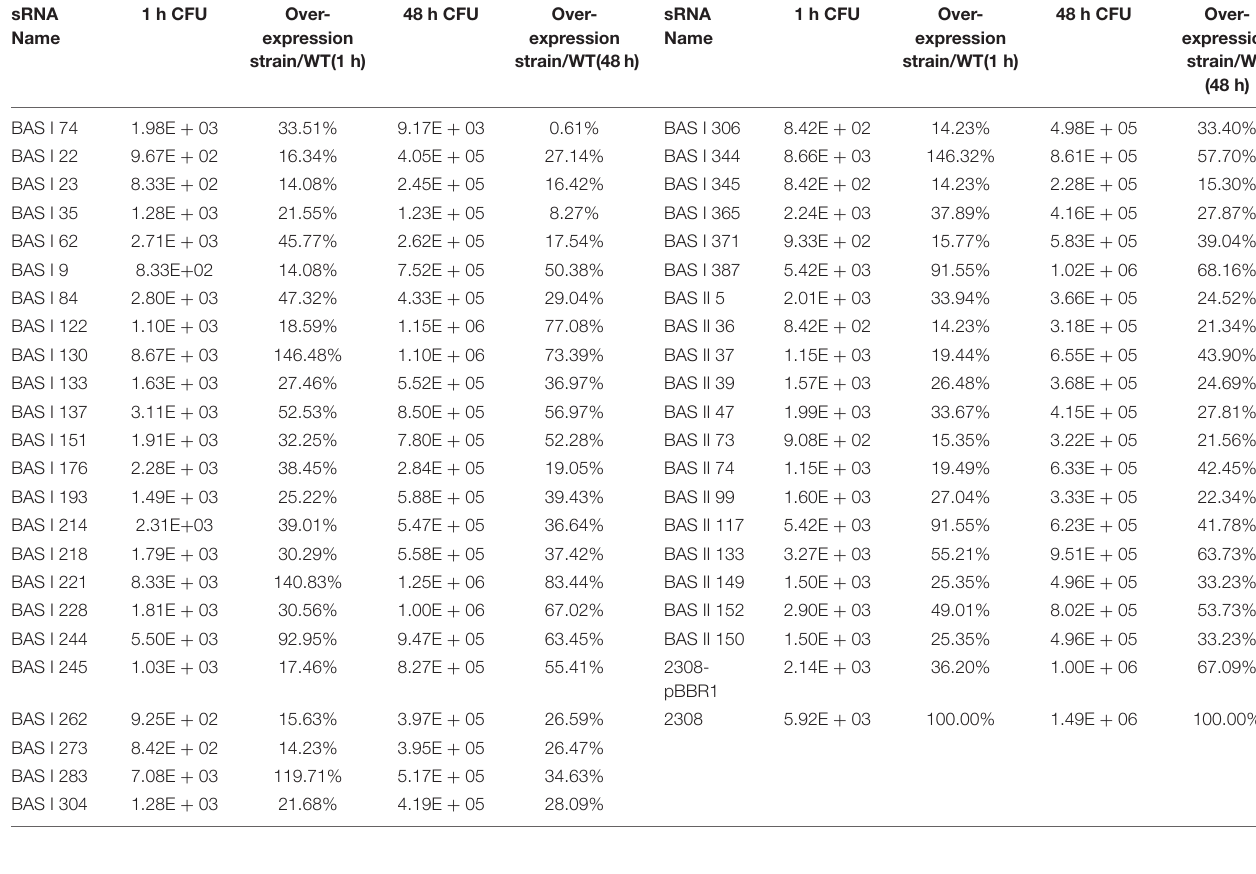
TABLE 2 | Multiplication ability of sRNA over expression strains in J774A.1 macrophages. sRNA Name